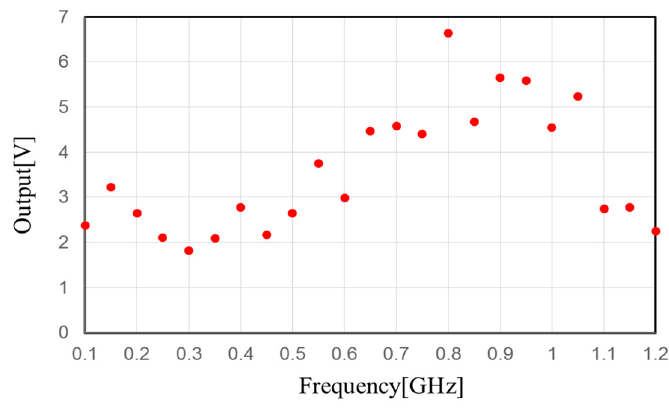
Figure 8. Measurement output voltage versus input RF signal.